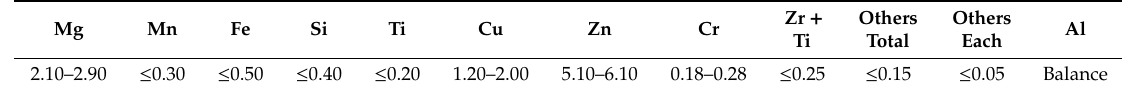
Table 3. Chemical composition of aluminium alloy 7075-T651 (wt %).